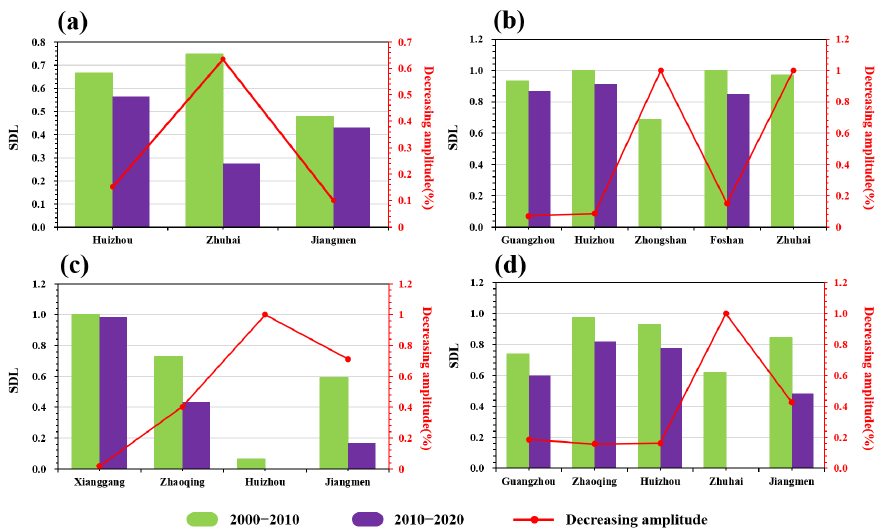
Figure 8. Comparison of areas where the sustainable development level (SDL) in the Guangdong- Hong Kong-Macao Greater Bay Area has declined and the decreasing amplitude. ( a ) is overall space; ( b ) is production space; ( c ) is living space; ( d ) is ecological